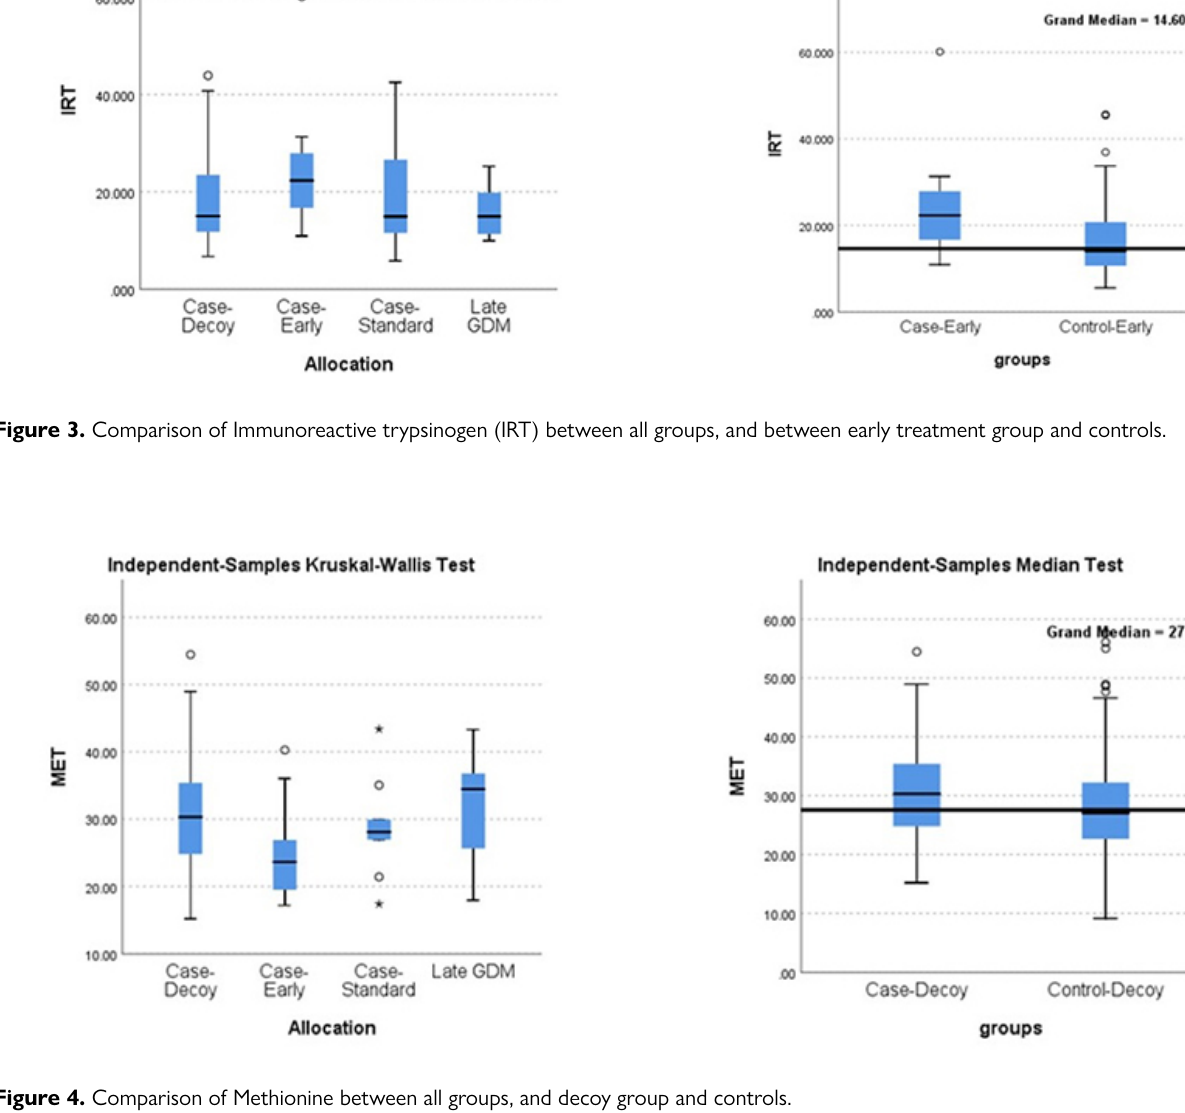
Figure 4. Comparison of Methionine between all groups, and decoy group and